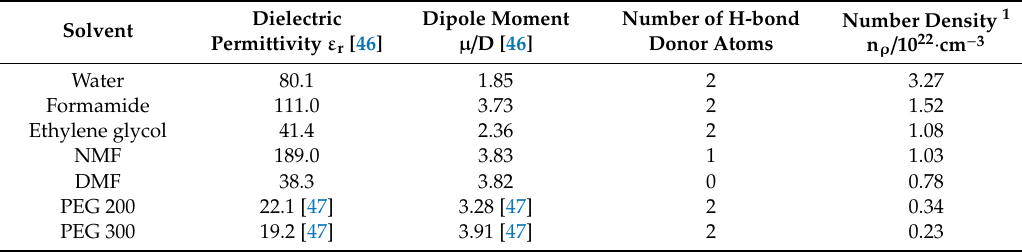
Table 2. Physical data of the solvents which were tested for the formation of a lyotropic SmC* with the amphiphile 4 . (Adapted from